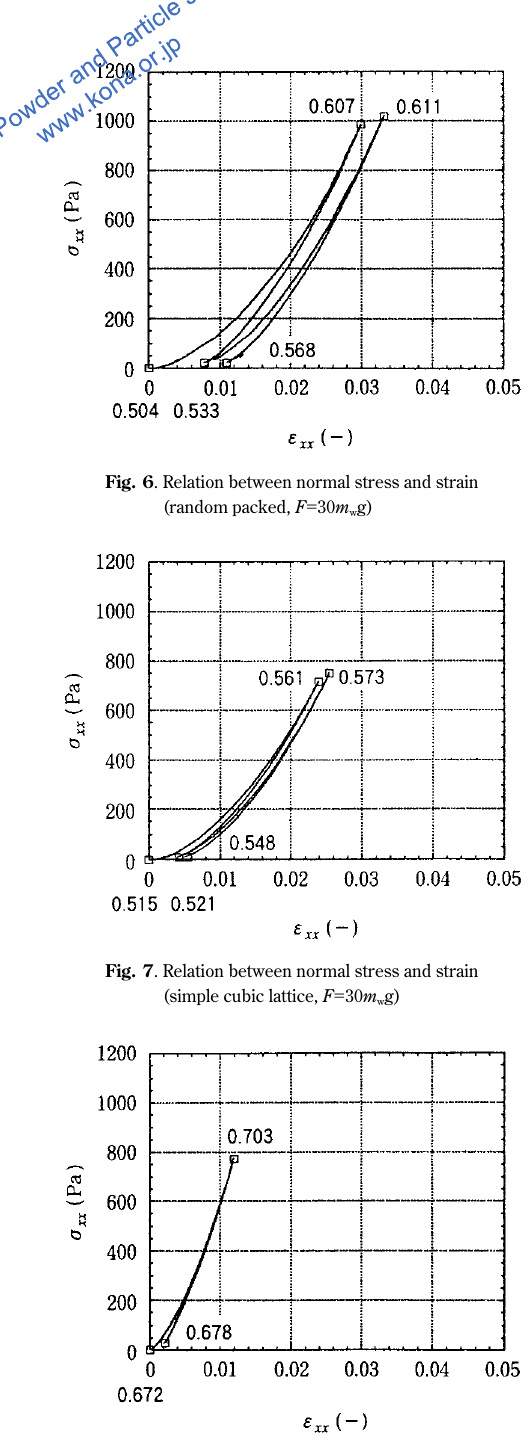
Fig. 8 . Relation between normal stress and strain (hexagonal closed-packed lattice, F = 30 m w